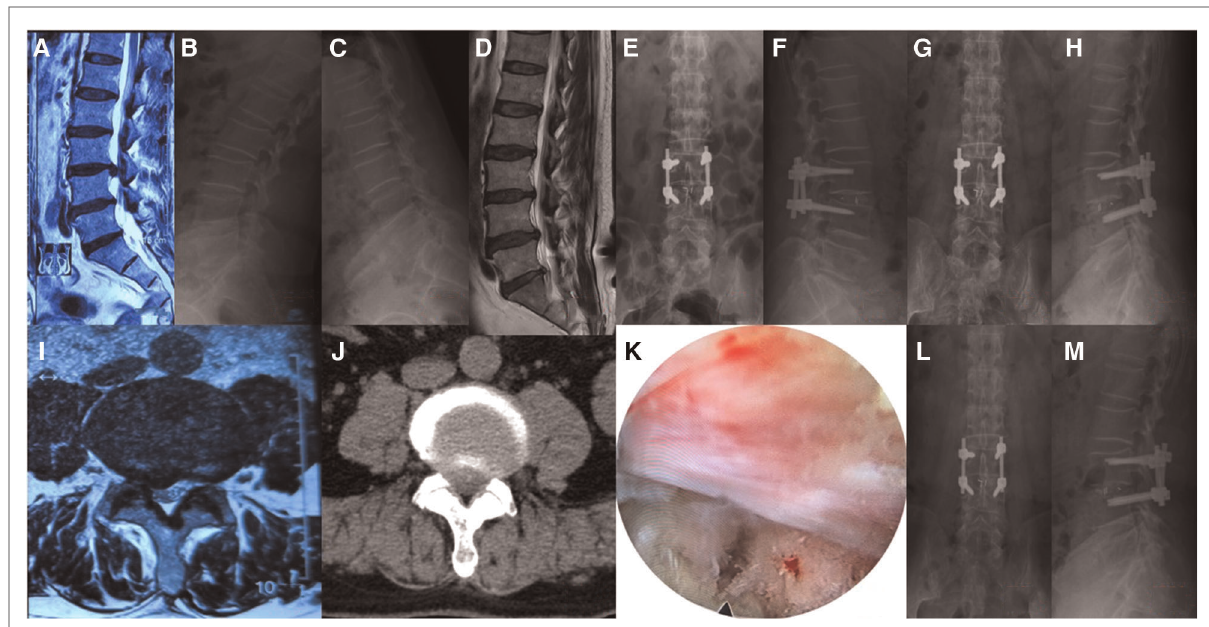
FIGURE 5 ( A ) preoperative MRI in sagittal position; ( B,C ) preoperative x-ray radiograph in lumbar dynamic position showing no lumbar instability or spondylolysis;( D ) sagittal MRI 6 months after surgery; ( E,F ) anteroposterior and lateral position x-ray radiographs 3 days after Mis-TLIF; ( G,H ) anteroposterior and lateral position x-ray radiographs 3 months after Mis-TLIF;( I ) preoperative MRI in coronal position; ( J ) preoperative CT in coronal position; ( K ) suf fi cient decompression of the nerve root was seen under the endoscope; ( L,M ) anteroposterior and lateral position x-ray radiographs 6 years after Mis-TLIF.